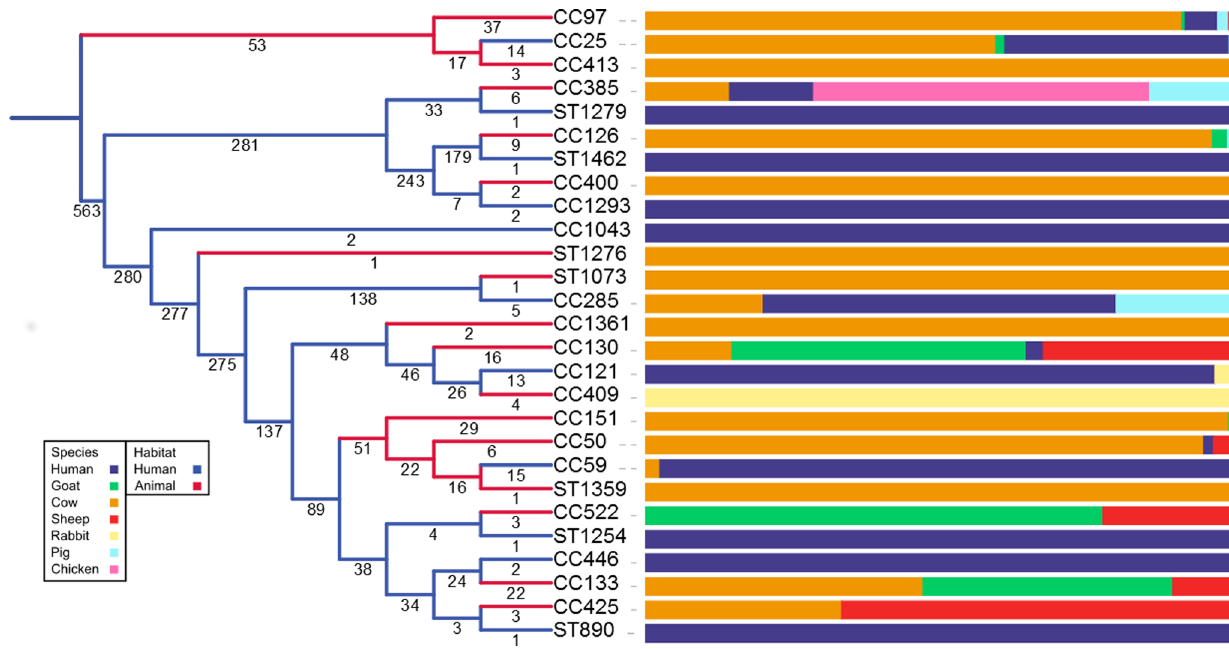
Figure 3. A pruned cladogram describing all 15 host switching events within the S.aureus population sample. Values attached to branches represent the number of unique STs entering each node, from left to right. Leaf labels indicate the defining ST or CC. Bars represent the distributions of isolates for each terminal clade, colours for each species are the same as in figure 1. Clades which underwent no switches are pruned from the tree at nodes where the branch containing them is uniform with the ancestral state. Branch colours represent the inferred habitat type (blue – human, red – animal). Asterisks mark points where host switching events occur.